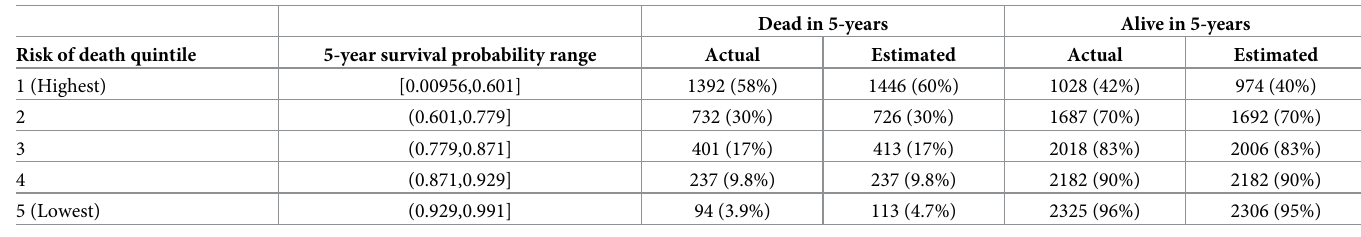
Dead in 5-years Alive in 5-years